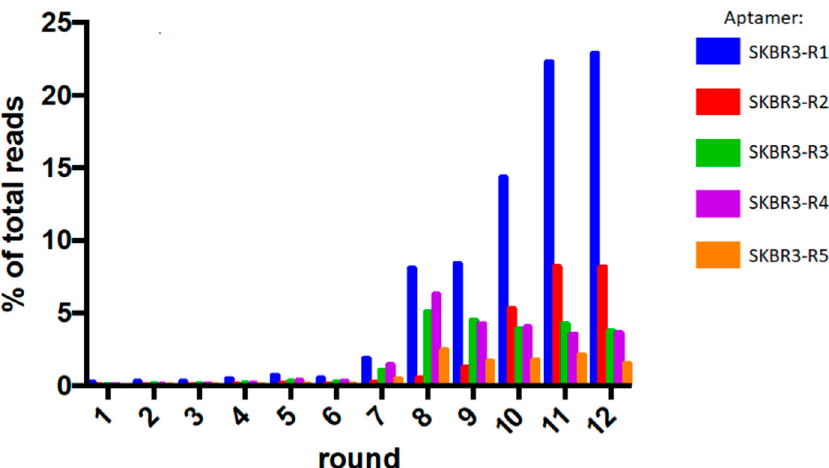
Figure 1. Graphical representation of the enrichment of the top 5 raised aptamer sequences in each round of the selection procedure. round of the selection procedure.